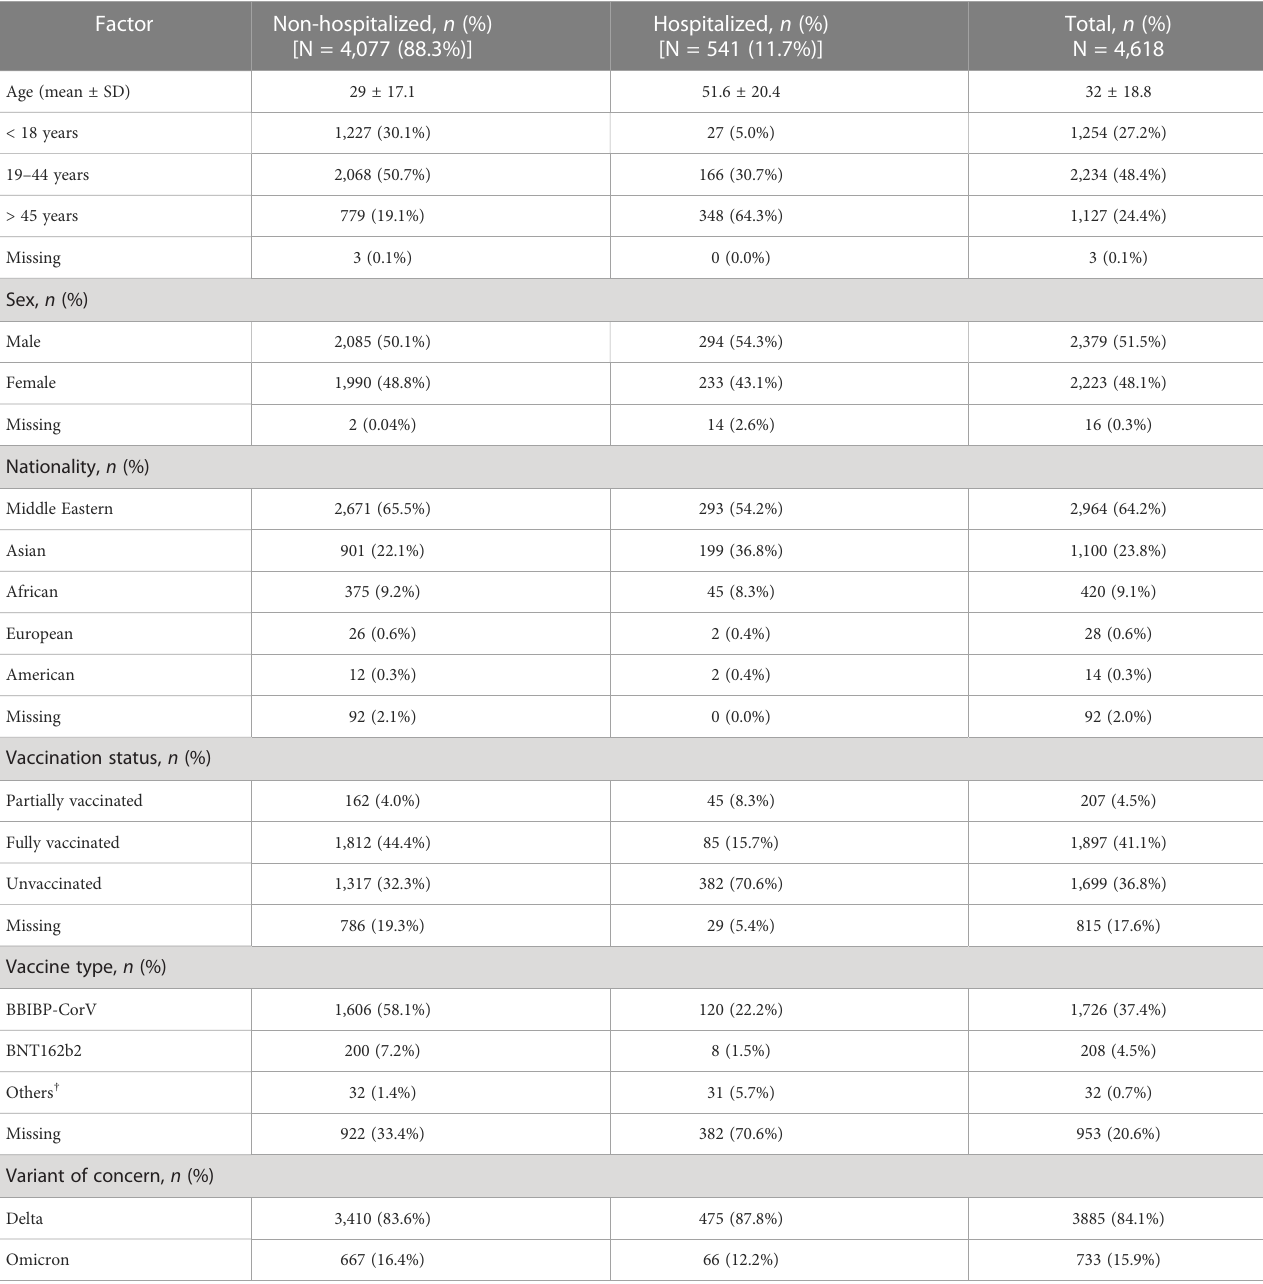
TABLE 1 Demographics and characteristics of study